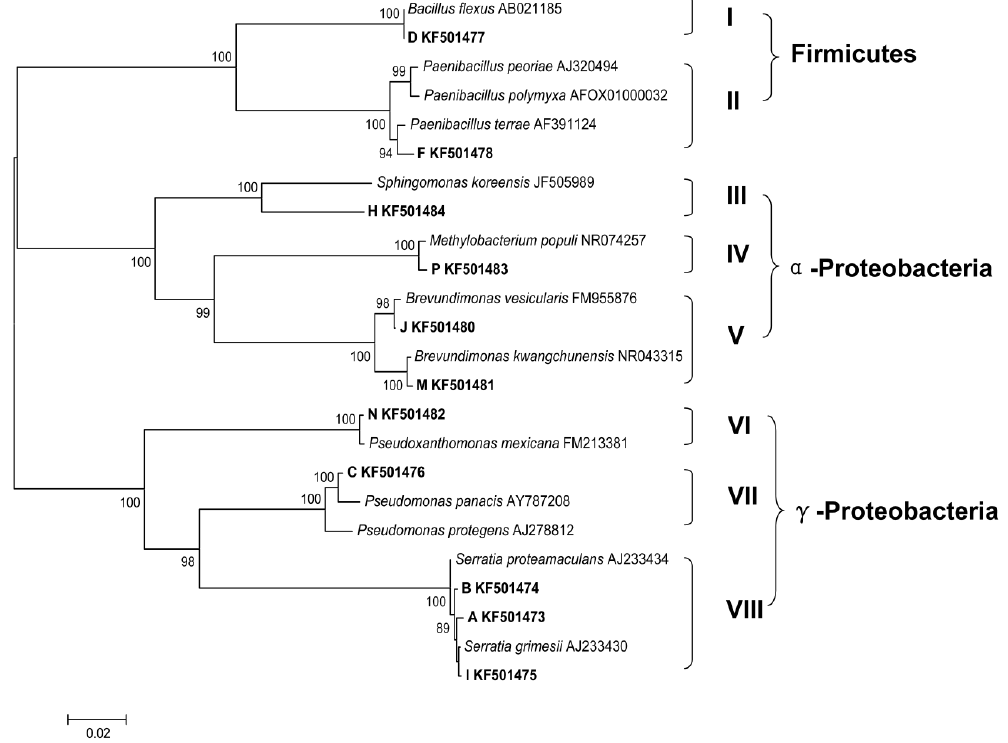
Figure 2. Neighbor-joining phylogenetic tree of 16S rRNA gene fragments of Dendroctonus armandi gut cellulolytic bacteria (enrichment isolates) (model: